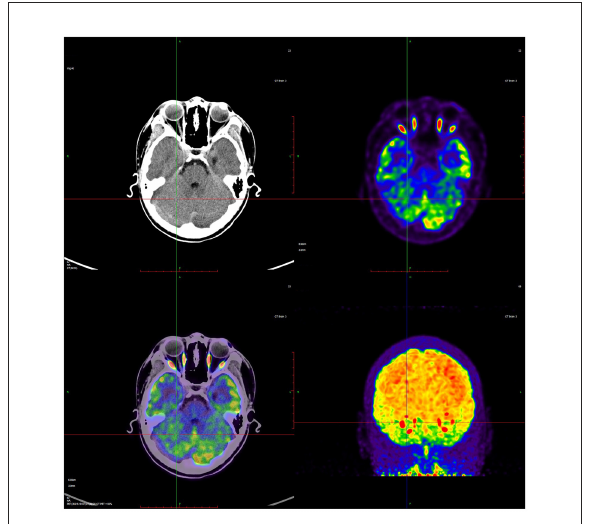
FIGURE1 A representative 18 F-FDG brain PET image from a CP child showed the relative higher glucose metabolism in left cortex. Red color indicates relatively high glucose metabolism and blue relatively low in comparison to corresponding regions.